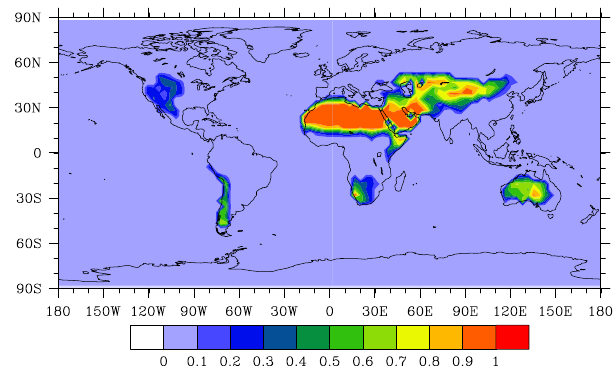
Fig. 1. An average over 12 monthly means of bare ground fraction ( F bg ) in potential dust source regions as prescribed in CanAM4-